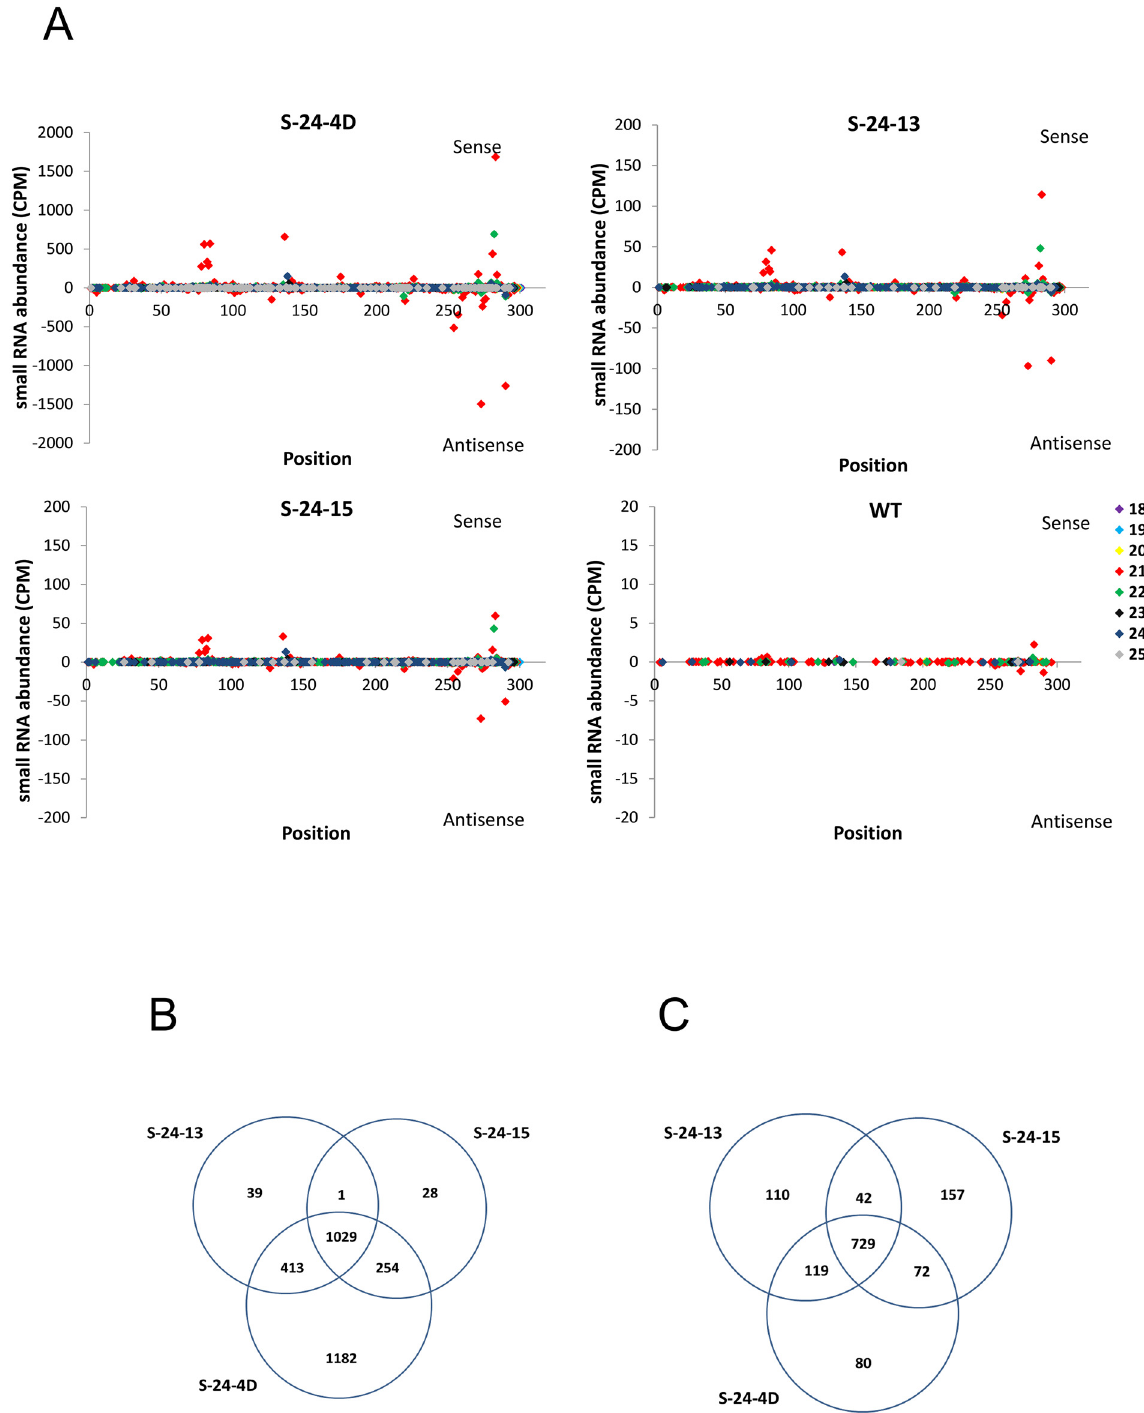
Fig 5. Comparison of 318-bp IR-derived siRNAs in the three RNAi lines. (A) Small RNAs matching the 318-bp IR were plotted versus the average of their normalized abundance from three replications. Plus Y-axis labels represent siRNAs from the sense strand of 318-bp region, while minus Y-axis indicate siRNAs found on the opposite strand. For visual clarity, the Y-axis of each diagram is adjusted based on the corresponding small RNA abundance. (B) and (C) Venn diagram represents common and specific reads from total and top 1000 abundant small RNAs in S-24-4D, S-24-13 and S-24-15, respectively.